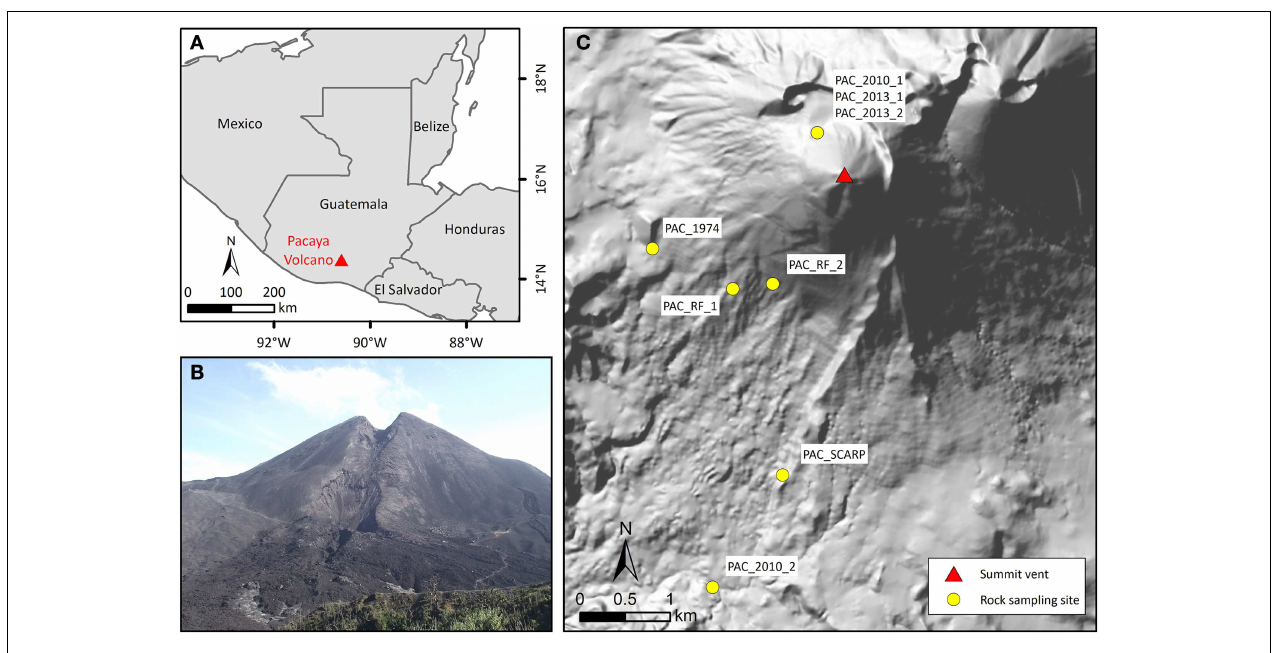
chosen for this study. See the Supplementary Image for a detailed volcanological map from Matías Gómez et al. (2012) with field site locations.